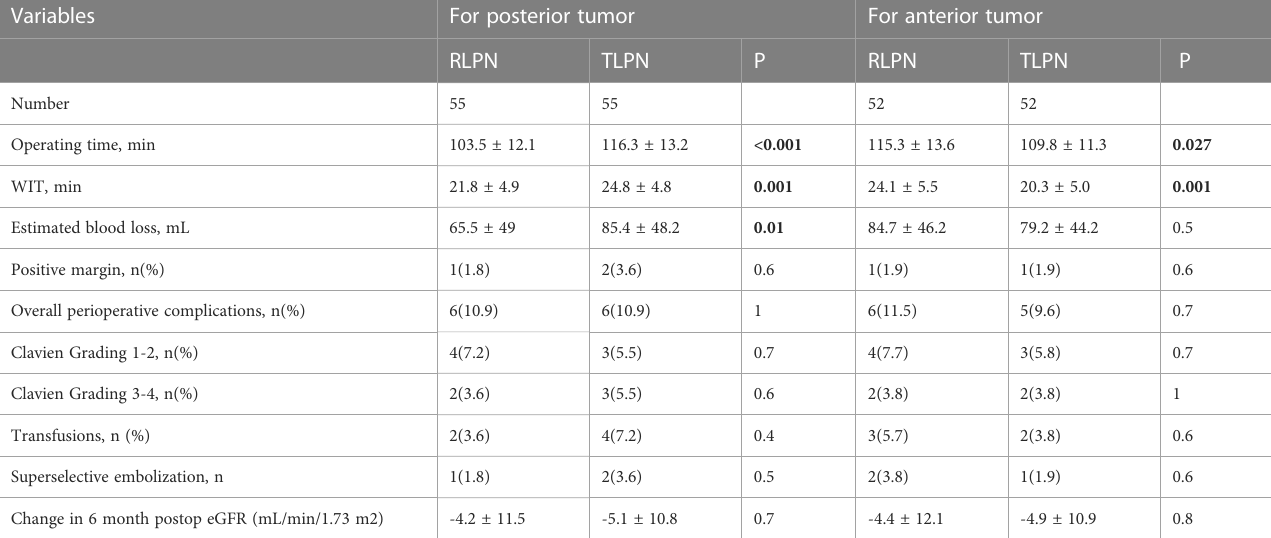
TABLE 3 Perioperative outcomes of patients with RLPN and TLPN subgrouped by tumor location. Variables For posterior